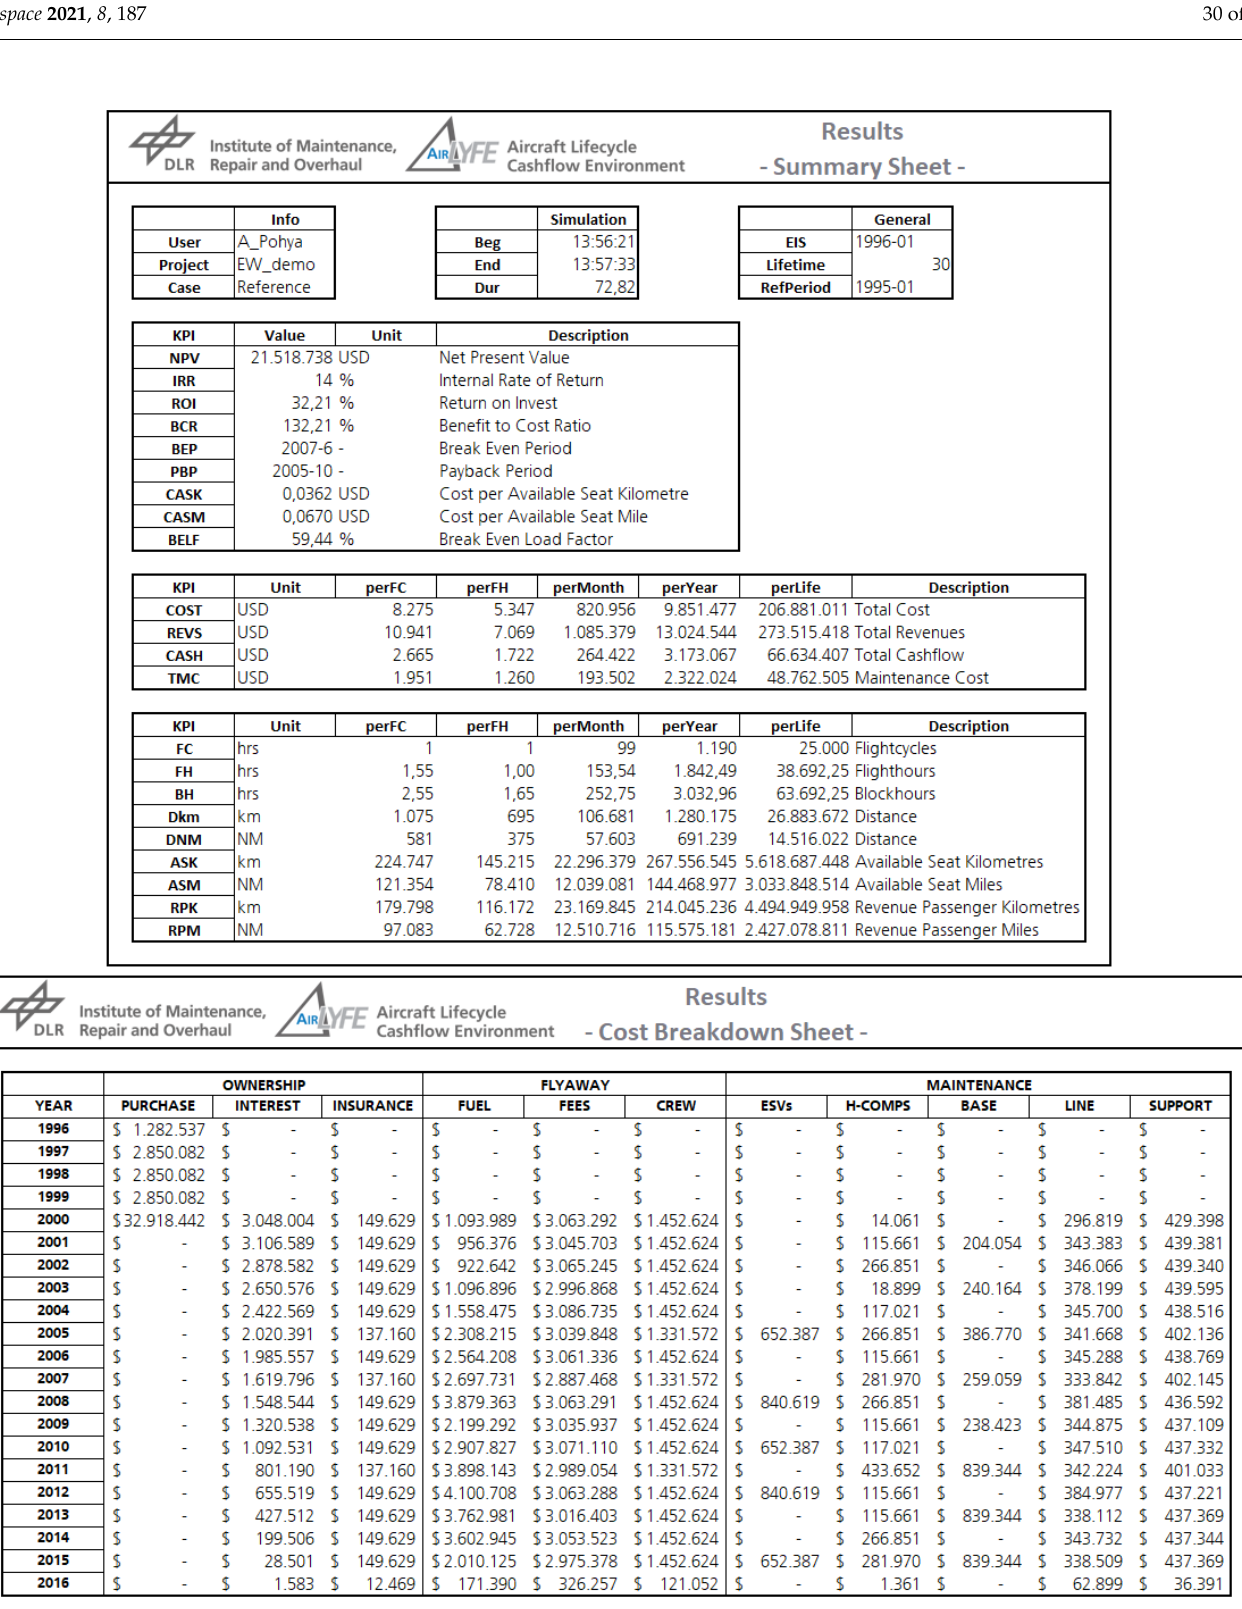
Figure A3. Excerpt of AirLYFE’s Excel-based report with summary sheet ( top ) and annual cost breakdown sheet ( bottom